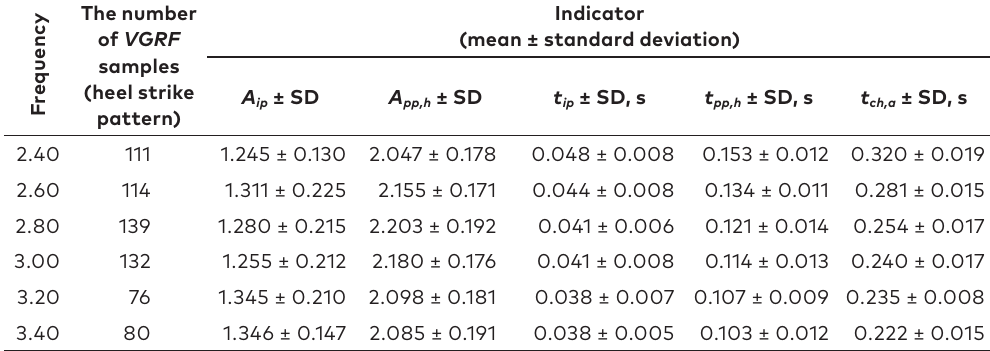
Table 1. The VGRF/G curve indicators – heel-strike running (mean value ± standard deviation (SD))